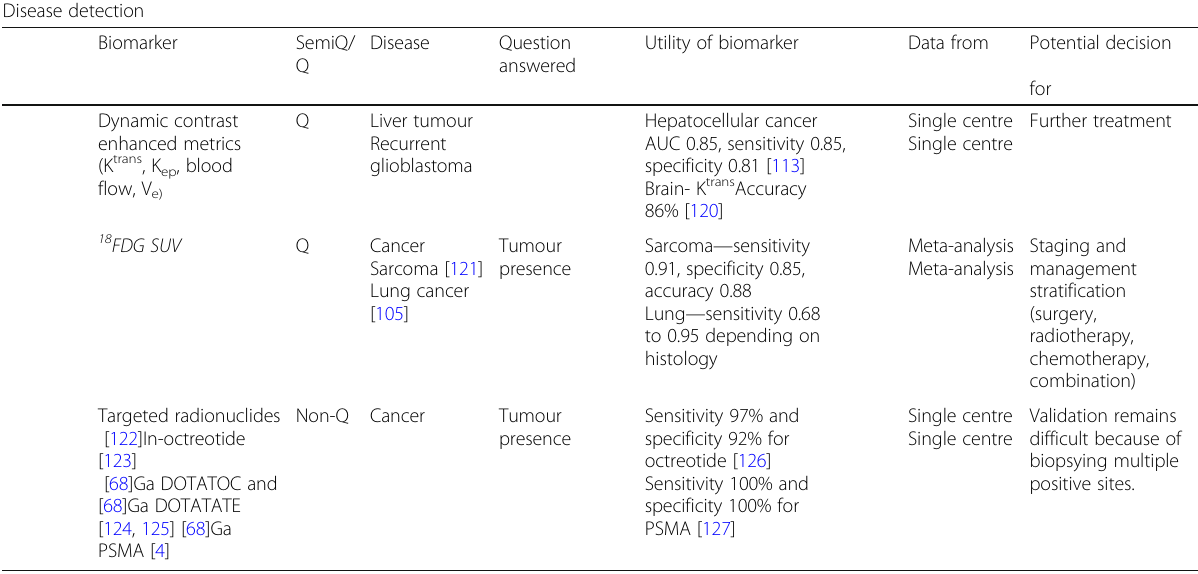
Table 1 Imaging biomarkers for disease detection (semi-quantitative and quantitative) with examples of current evidence for their use that would support decision-making